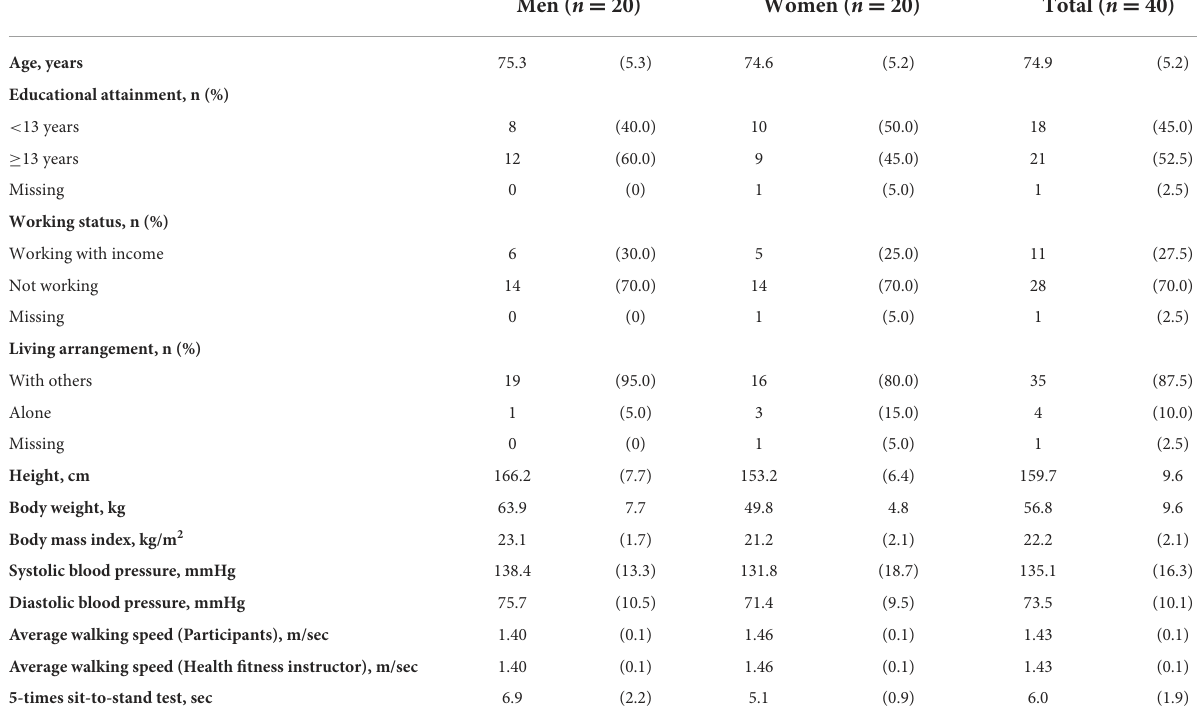
TABLE 1 Characteristics of the study participants.